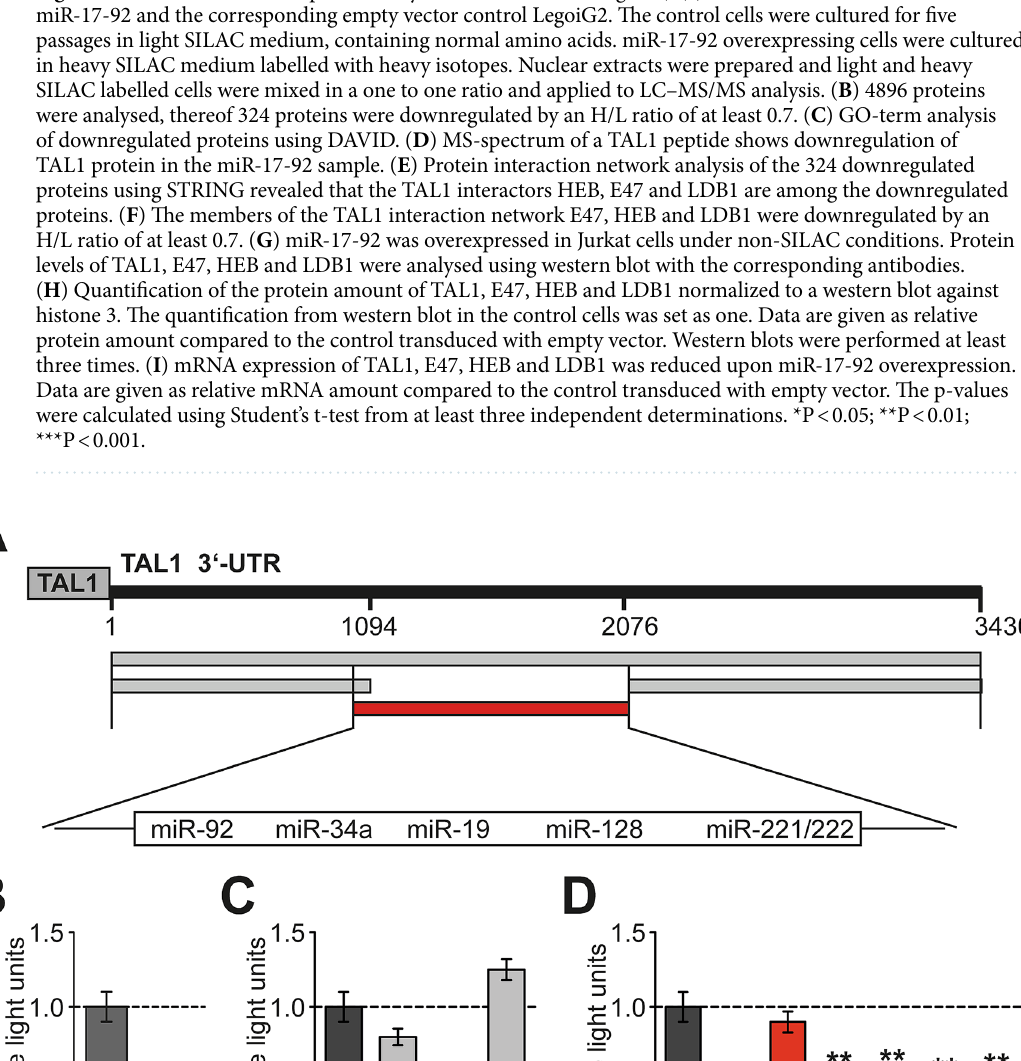
Figure 2. A miR-19 binding site in the 3 ′ -UTR of TAL1 mediates repression. ( A ) Outline of the 3430 bp long 3 ′ -UTR of TAL1. Using TargetScan several miRNA binding sites within the 3 ′ -UTR of TAL1 were identified 74 . MiRNA binding sites are shown, among others miR-19 and miR-92 of the miR-17-92 cluster. The whole length 3 ′ -UTR and three deletion constructs from position 1–1094, 1075–2076 and 2076–3430 were cloned into pMirTarget behind a luciferase reporter gene. ( B ) Luciferase reporter gene assay was performed in K562 cells. The full-length construct of the TAL1 3 ′ -UTR exhibited lower luciferase activity compared to the empty vector control. Data are shown as relative light units gathered from at least three independent transfections. Values gathered with empty vector were set as one. ( C ) Luciferase reporter assay with three deletion constructs of the TAL1 3 ′ -UTR. The middle fragment from position 1075–2076 (red bar) displayed a reduced luciferase activity. The other tested fragments did not alter the luciferase activity. Data are shown as relative light units gathered from at least three independent transfections. Values gathered with empty vector were set as one. ( D ) The microRNA binding sites in the middle part of the 3 ′ -UTR were mutated. The mutation of the binding site of miR-19 led to a loss of the repressive effect. Data are shown as relative light units gathered from at least three independent transfections. Values gathered with empty vector were set as one. The p-values were calculated using Student’s t-test from at least three independent determinations. **P < 0.01; ***P <